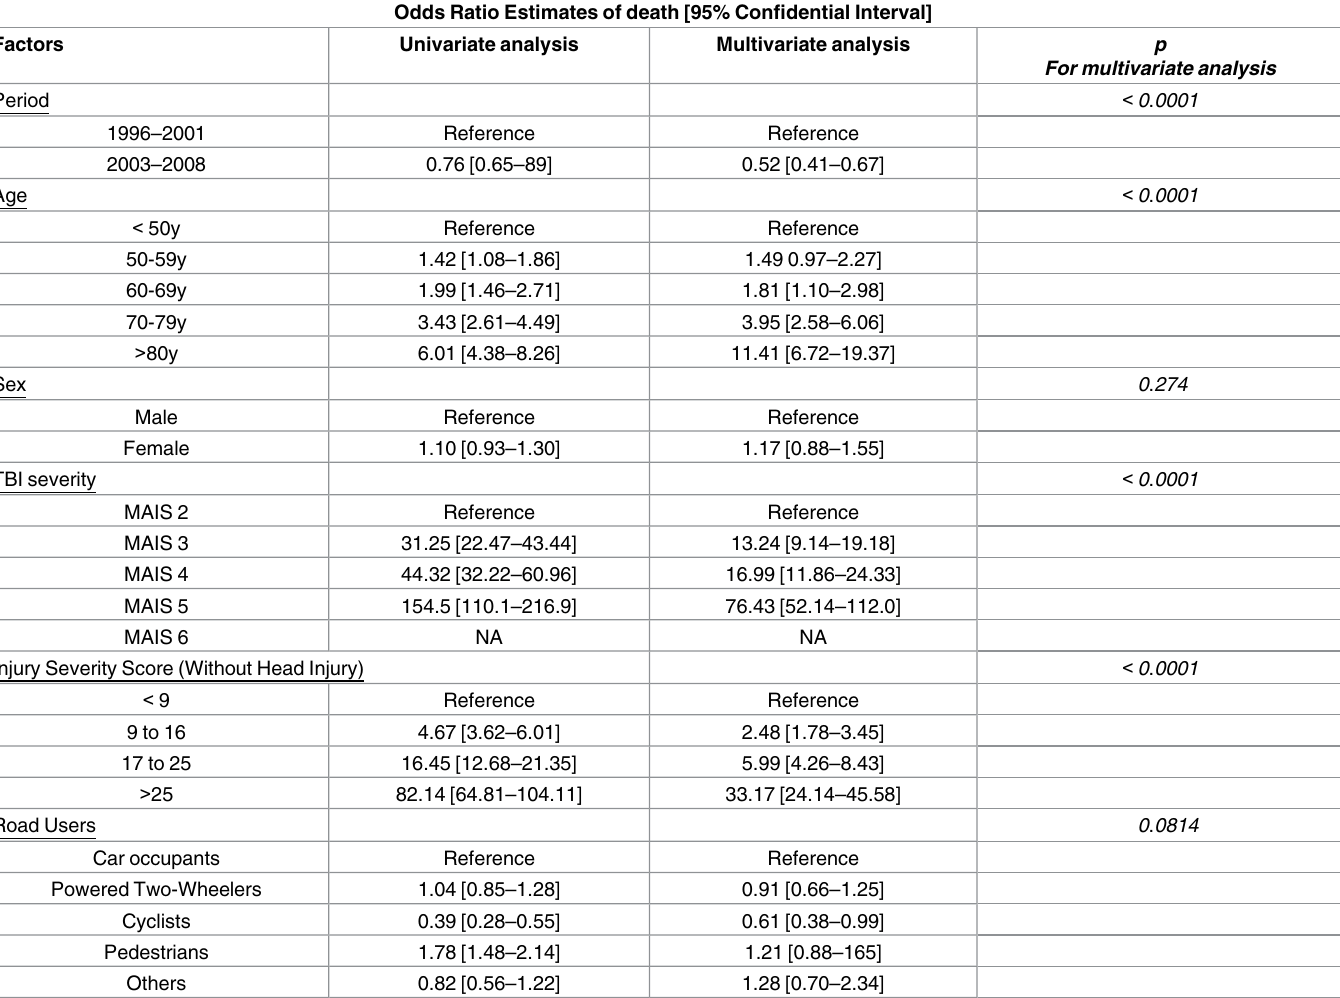
Table 6. Logistic regression analysis of the odds ratio of TBI-related deaths after RTC, adjusted for age, sex, period, AIS severityof the TBI and ISS excluding the head trauma. Odds Ratio Estimates of death [95% Confidential